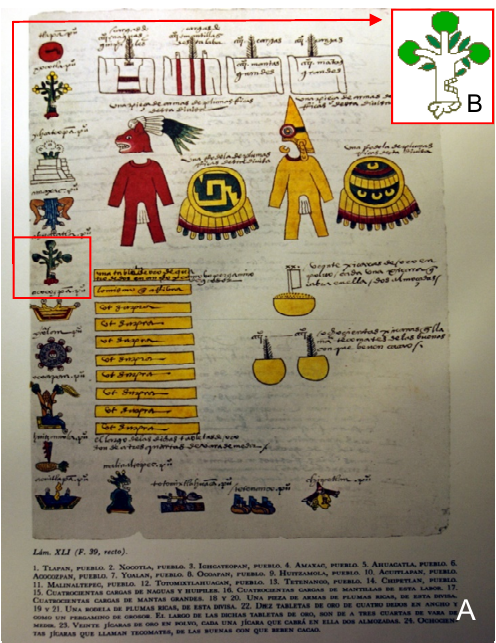
Figure 1. Pictographic script from the Mendoza Codex ( A ) with an illustration of Ahuacatlan town represented by an avocado tree ( B ) (fifth from top left). The teeth drawing on the trunk means “place”. Ahuacatlan means “place where avocados grow”.